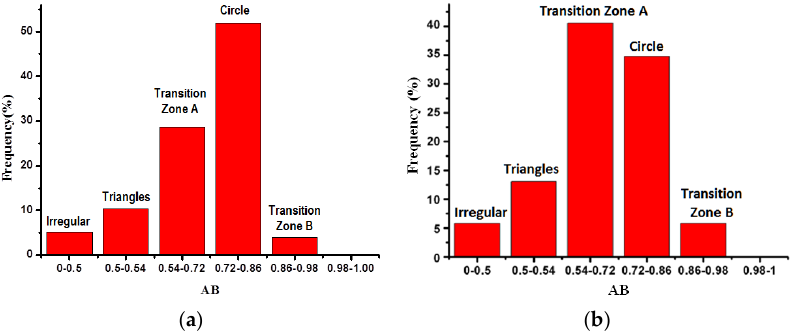
Figure 6. The proportion of AB parameters for different corroded reinforcement: ( a ) RT ‐ P4; ( b ) RTL ‐ P4. The maximum and average values of arithmetical mean deviation ( R a ) of surface profiles at eight lines as described above were calculated and are shown in Table 4. Under the condition of similar corrosion mass loss ratio ( S ), the surface roughness of the RT specimen is found to be lower than that of the RTL specimen, which indicates that the coupled chemo ‐ mechanical process affects the distribution of pitting depth [41]. Table 4. Surface roughness of corroded reinforcement. R a : Arithmetical mean deviation.